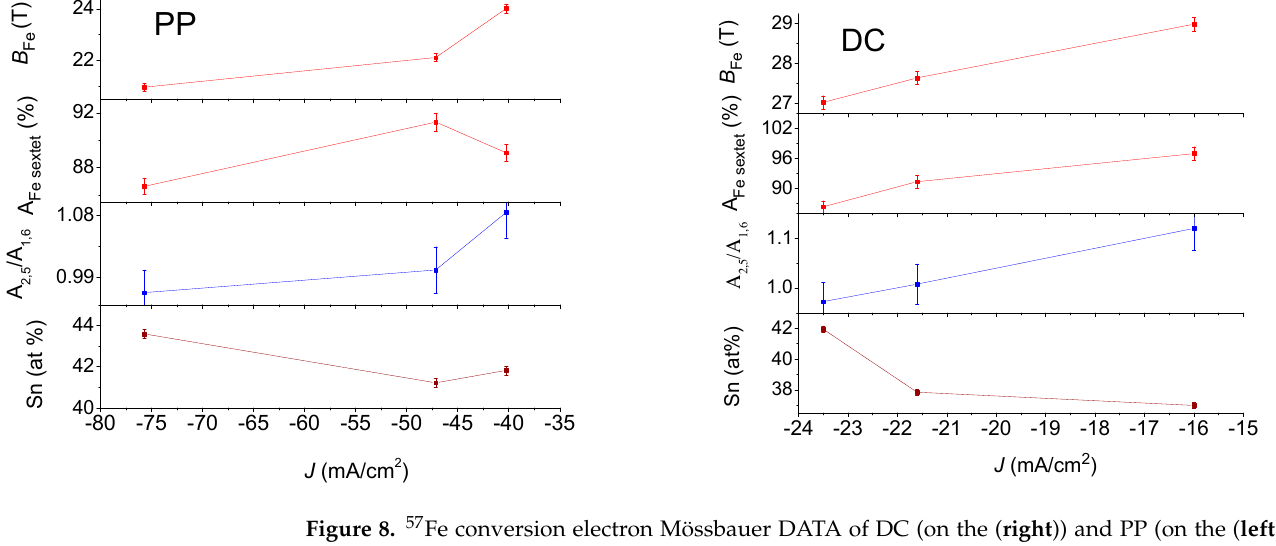
Figure 8. 57 Fe conversion electron Mössbauer DATA of DC (on the ( right )) and PP (on the ( left )) electrodeposited quaternary Sn-Fe-Ni-Co alloy coatings together with Sn content with the current densities.